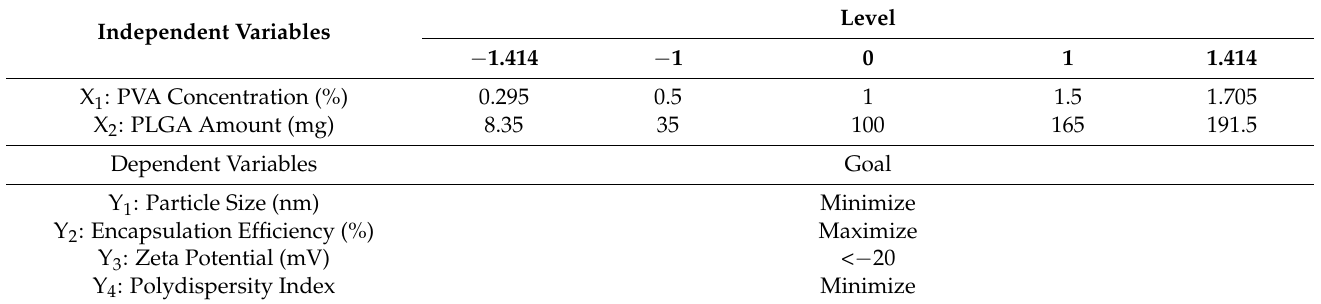
Table 6. Applied dependent factors in the central composite design